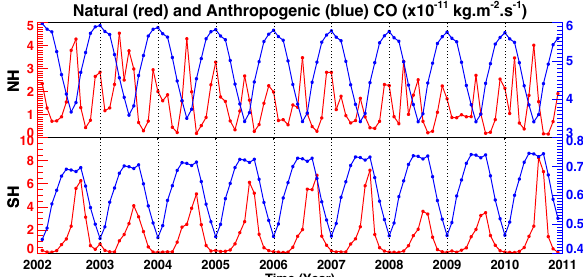
Figure 8a. The variability of AIRS CO recent emissions (red dotted curves) and that of other inventory data (green dotted curves), i.e., the total amount of GFED3 biomass burning and MACCity anthropogenic emissions without biomass burning, for the NH (upper panel) and the SH (lower panel). The smoothed AIRS CO recent emissions (red solid curve), and the smoothed inventories (green solid curve) are also shown. A second-degree polynomial is used for the smoothing.